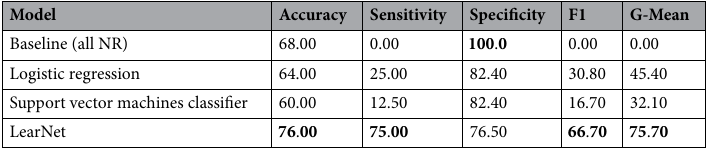
Table 2. Classification results. For each metric, the best performances is reported in